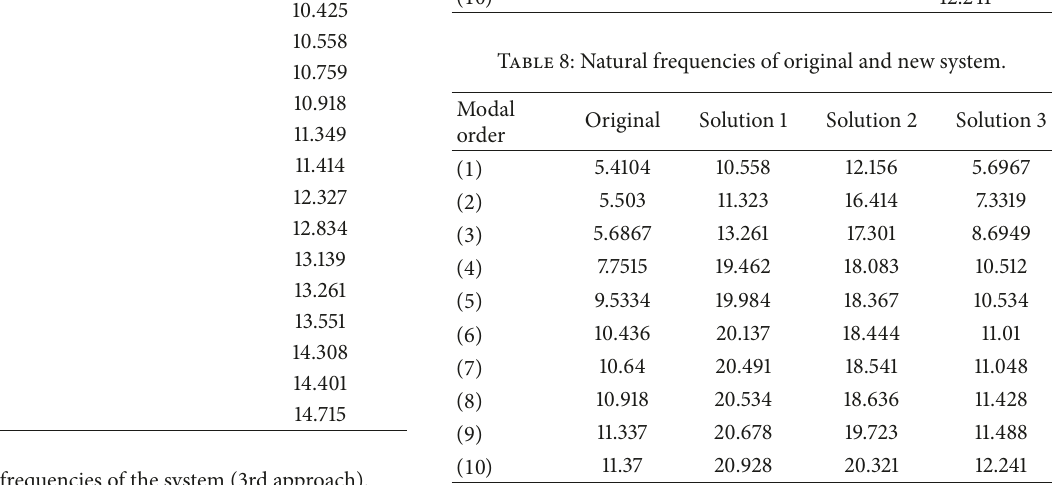
Table 5: Natural frequencies of the system (3rd approach).